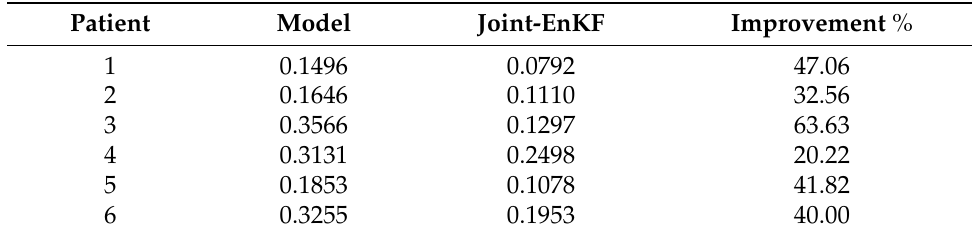
Table 2. Bias of the predicted viral load using the model free-run and the joint-EnKF and improvement (%) with respect to the model.